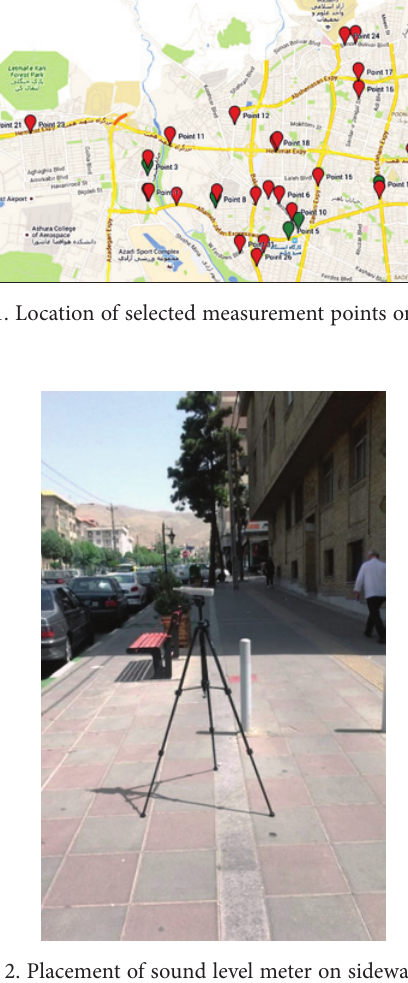
Figure 2. Placement of sound level meter on sidewalk to measure traffic noise